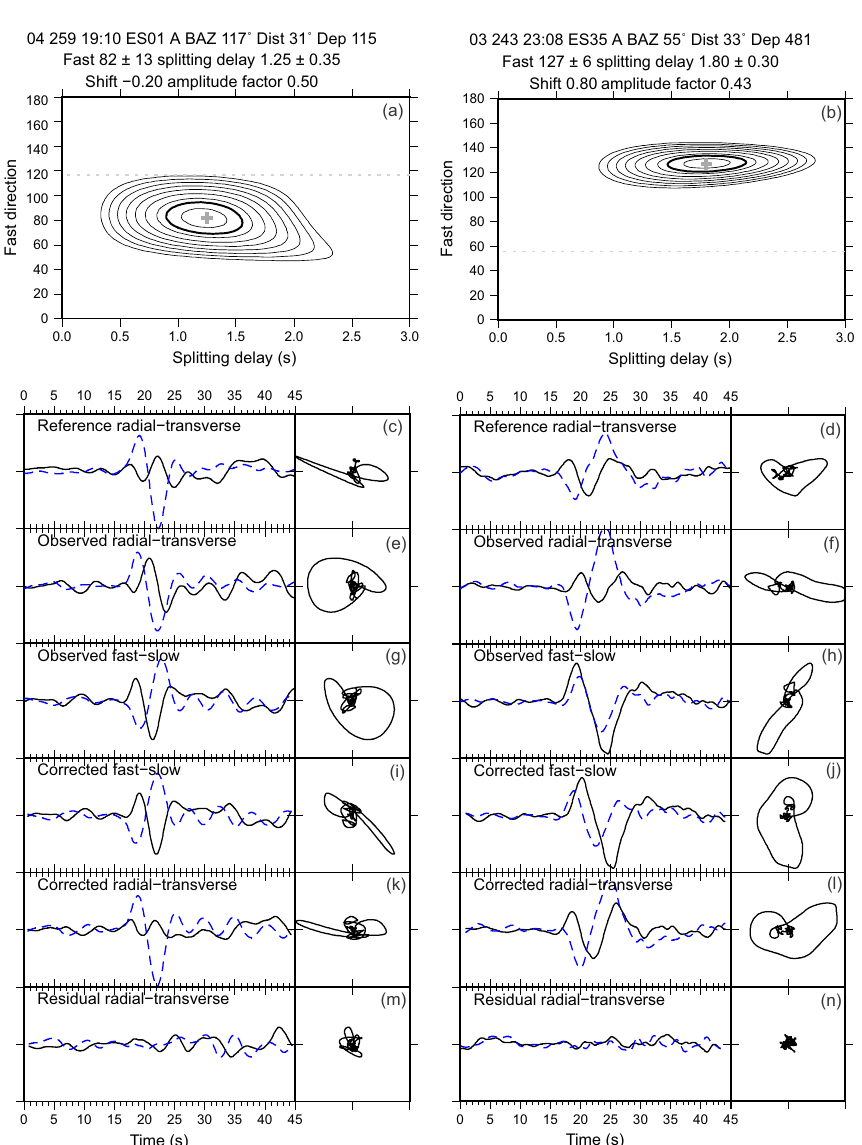
Figure 3. Examples of the direct S wave splitting measurements based on the reference station technique at stations ES01 and ES35. Figures on the left side represent the splitting measurement recorded at station pair ES03 (reference station)–ES01 (target station), and those on the right side represent the splitting measurement recorded at station pair ES16 (reference station)–ES35 (target station). (a) Misfit surface with splitting parameter 82 ◦ ± 13 ◦ and 1.25 ± 0.35s. (c) Signal at reference station (ES03) with receiver-side correction. (e) Signal at target station (ES01). (g) Fast and slow component after rotating signal at target station (ES01) using φ (82 ◦ ). (i) Fast and slow component corrected for δt (1.25s). (k) Corrected radial and transverse components at target station (ES01) using optimum φ and δt and isotropic delay ( − 0.2s). (m) Residual trace. Panels on the right side follow the same order and